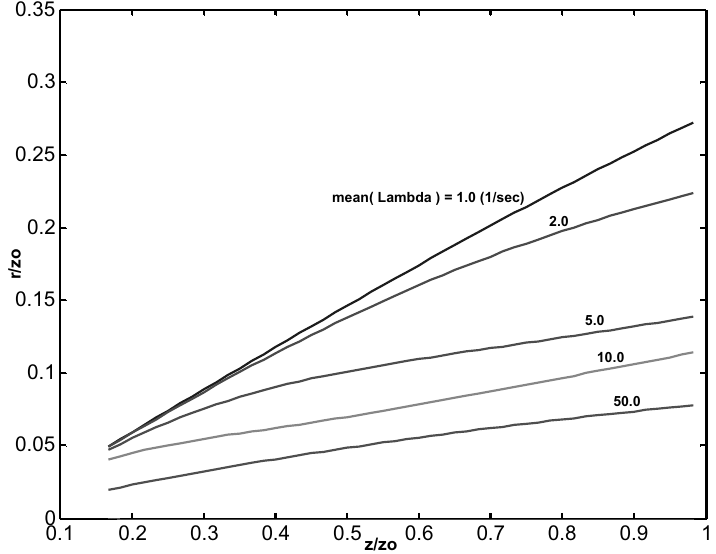
Fig. 9. Variation of the normalized radial location of the critical point for liquefaction with the normalized depth (for several values of the mean time-decay constant of the applied load). exponential-load parameters in this investigation also increases the probability of